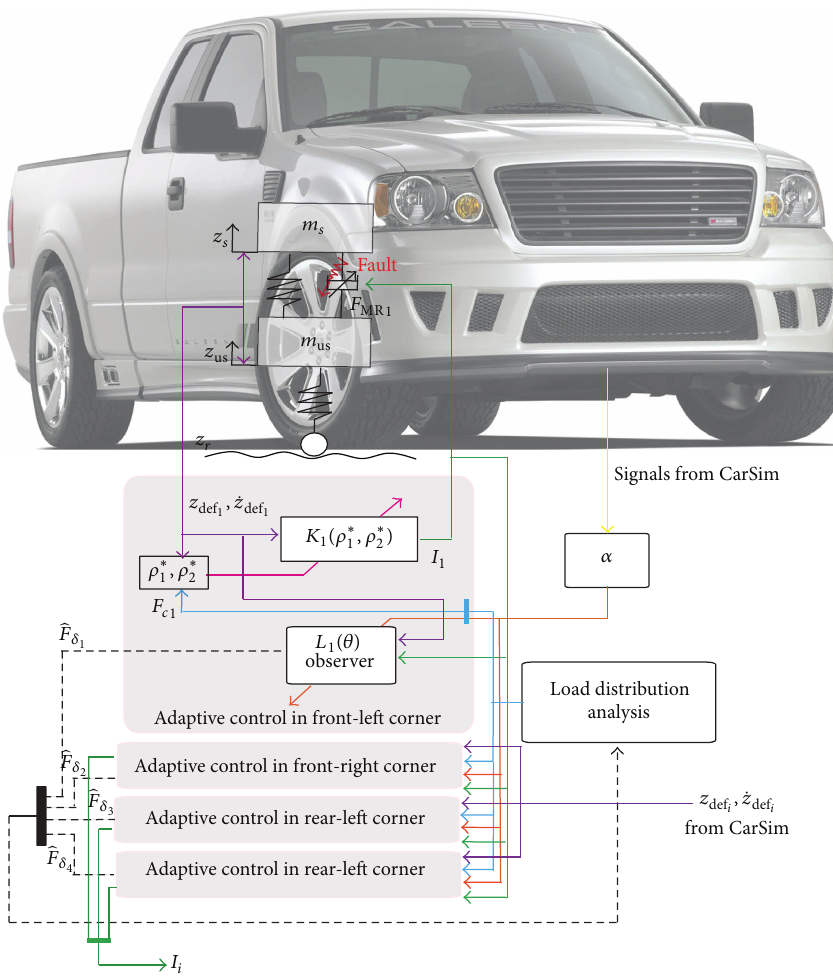
Figure 8: Adaptive suspension control system for MR damper